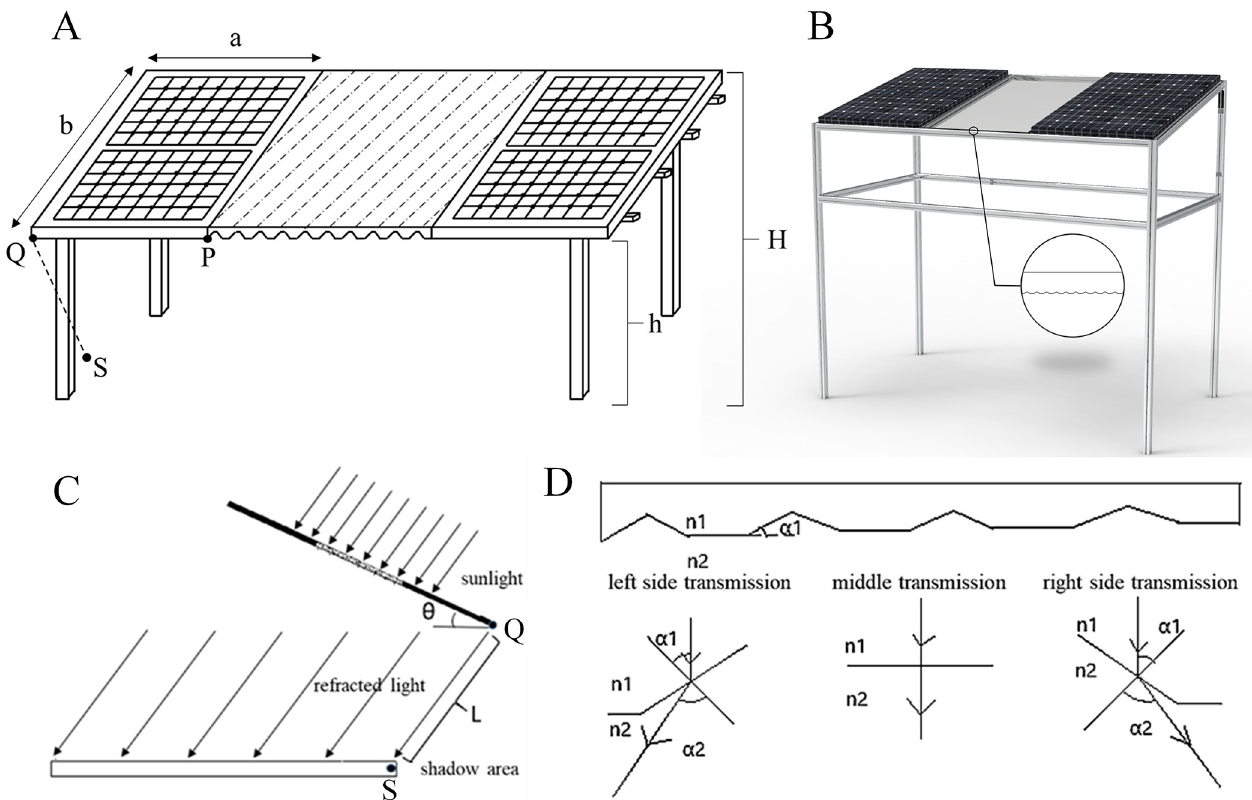
Fig 1. The structure of the EAS (A). The rendered output diagram of EAS structure (B). The side view of the EAS (C). The structure of the grooved glass plate (D).